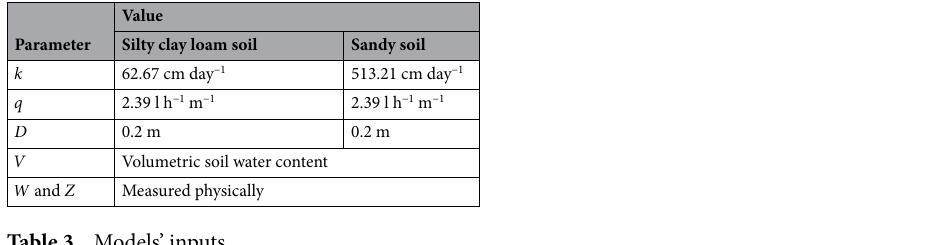
Table 3. Models’ inputs.